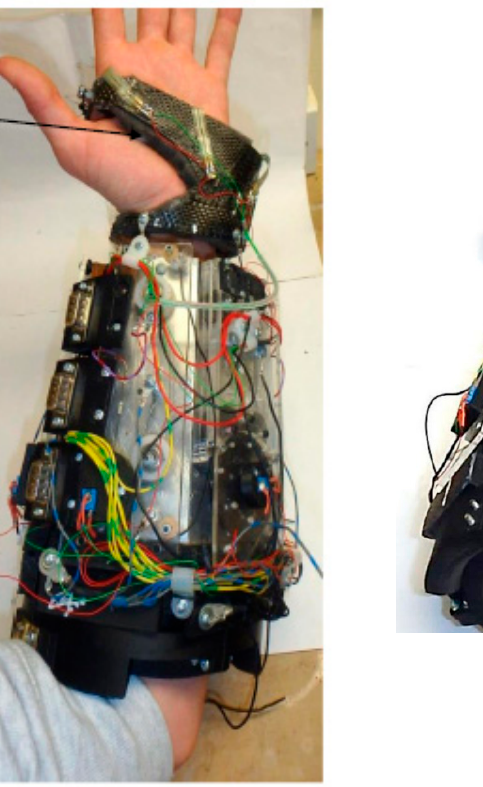
Figure 14. Three degrees of freedom prototype developed by Hope et al. for hand and forearm assistance [36].